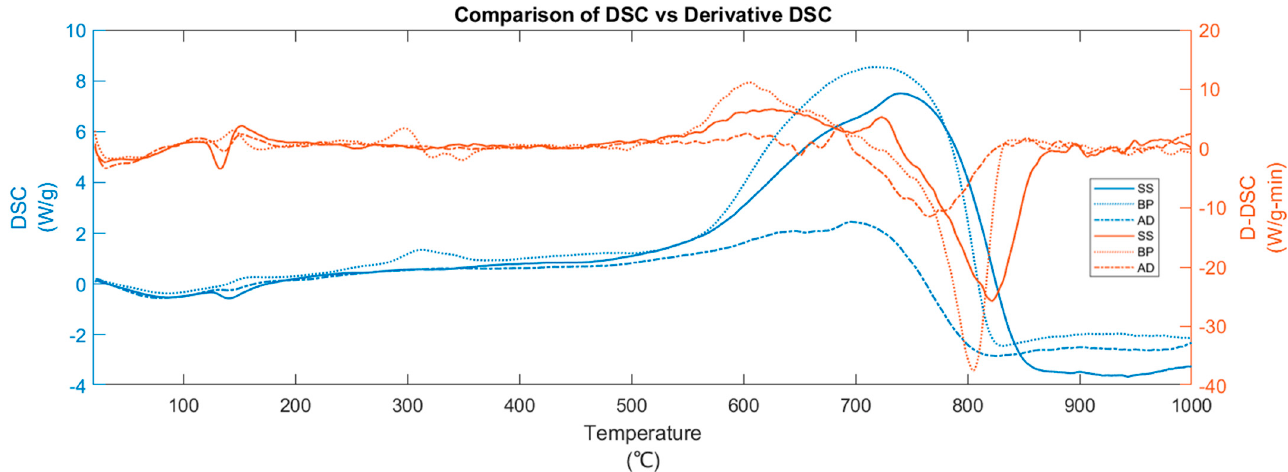
Figure 4. Change in Heat of Pyrolysis (HoP) and biochar yield of BP, SS, and AD with process temperature.